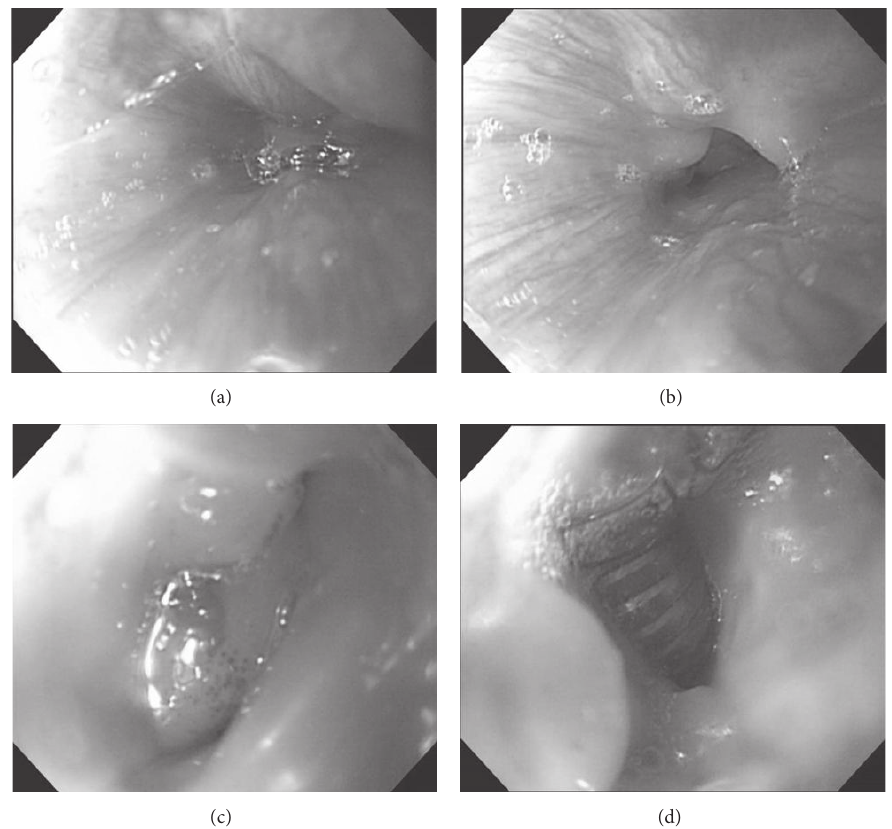
Figure 3: Esophagoscopy. (a) The esophageal orifice was visible on esophagoscopy. (b) Strangulation in the cervical esophagus was present. (c) Granulation tissue had developed. (d) A defect in the esophageal wall was present, and the tracheal tube was visible.